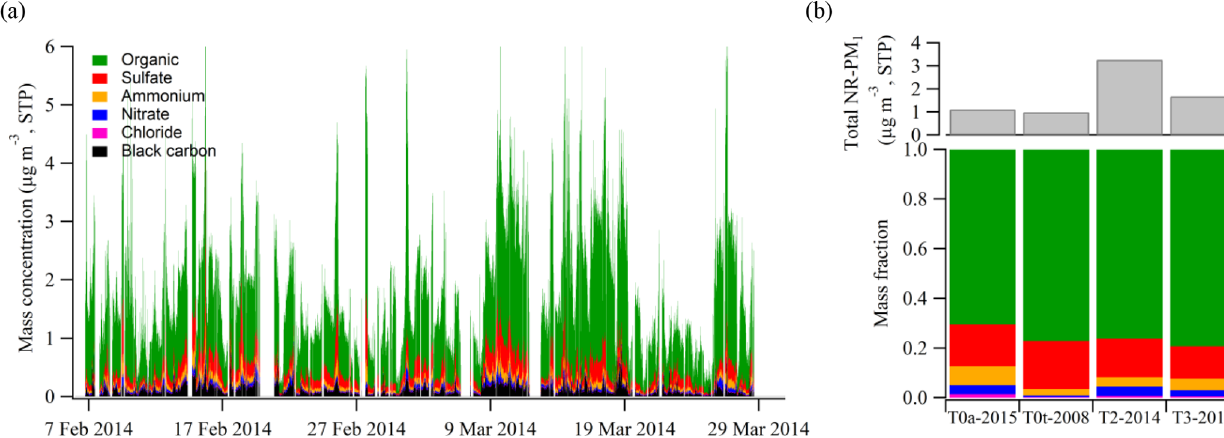
Figure 1. (a) Mass concentrations of PM 1 species at T3 during the wet season of 2014 (IOP1). Non-refractory (NR) PM 1 species of organic, sulfate, ammonium, nitrate, and chloride were measured by the AMS. Mass concentrations of black carbon were obtained by scaling aethalometer measurements by a factor of 2 based on the range of 1 to 3 for the comparison of SP2 to aethalometer measurements. The temporal trend of the two instruments agreed well. (b) Comparison of the summed mass concentrations of (top) non-refractory PM 1 species and (bottom) the mass fractions of these species at T3 and three other regional sites. T0a-2015 refers to measurements in the wet season of 2015 at the ATTO location (Andreae et al., 2015). T0t-2008 refers to the AMAZE-08 experiment, which took place in the wet season of 2008 at the TT34 location (Chen et al., 2015). T2-2014 refers to measurements made during IOP1 at a site 8km downwind of Manaus, just across the Black River (“Rio Negro”) (Cirino et al., 2018). Measurements at T0a in 2015 and at T2 in 2014 were made by an ACSM, and measurements at T0t in 2008 and at T3 in 2014 were made by an AMS. Concentrations were adjusted to standard temperature (273.15K) and pressure (10 5 Pa) (STP). The variability of measurements across sites is evaluated in Fig. 2.